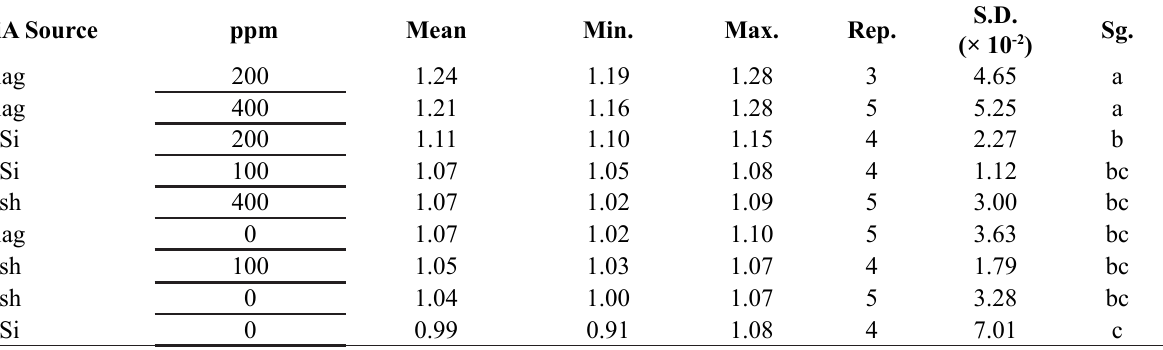
Table 3. Statistical summary of the soil electrical conductivity - ECe (dS.m -1 ) data at the end of the campaign, transformed with . Significance levels were obtained from Tukey test, α = 0.05.